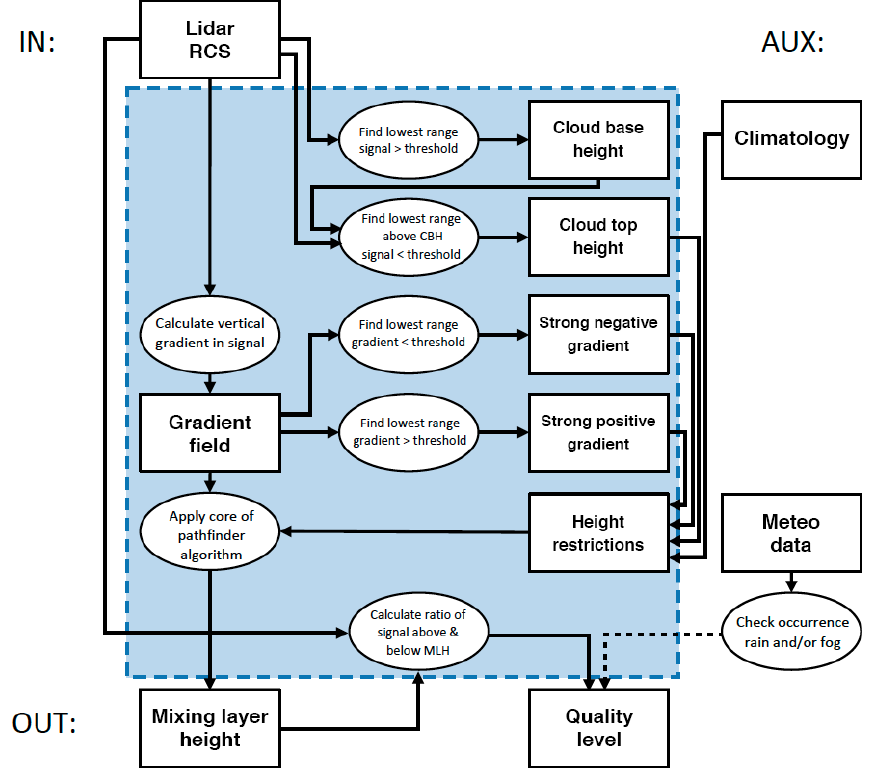
Figure 1. Flow diagram of the pathfinder algorithm. Internal operations and variables are grouped within the blue area. Input data are shown at the top and output variables at the bottom. Auxiliary data are displayed on the right. The use of collocated meteorological data is